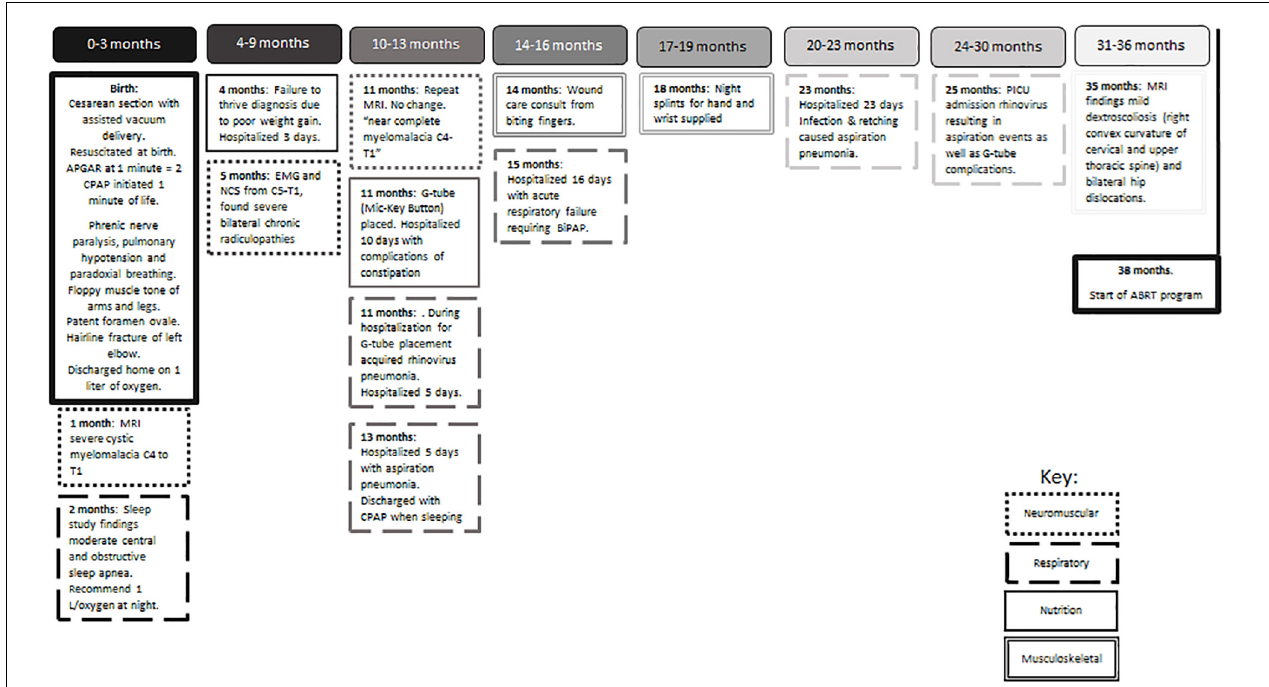
FIGURE 1 | Timeline of medical care required from birth to enrollment in ABRT (38